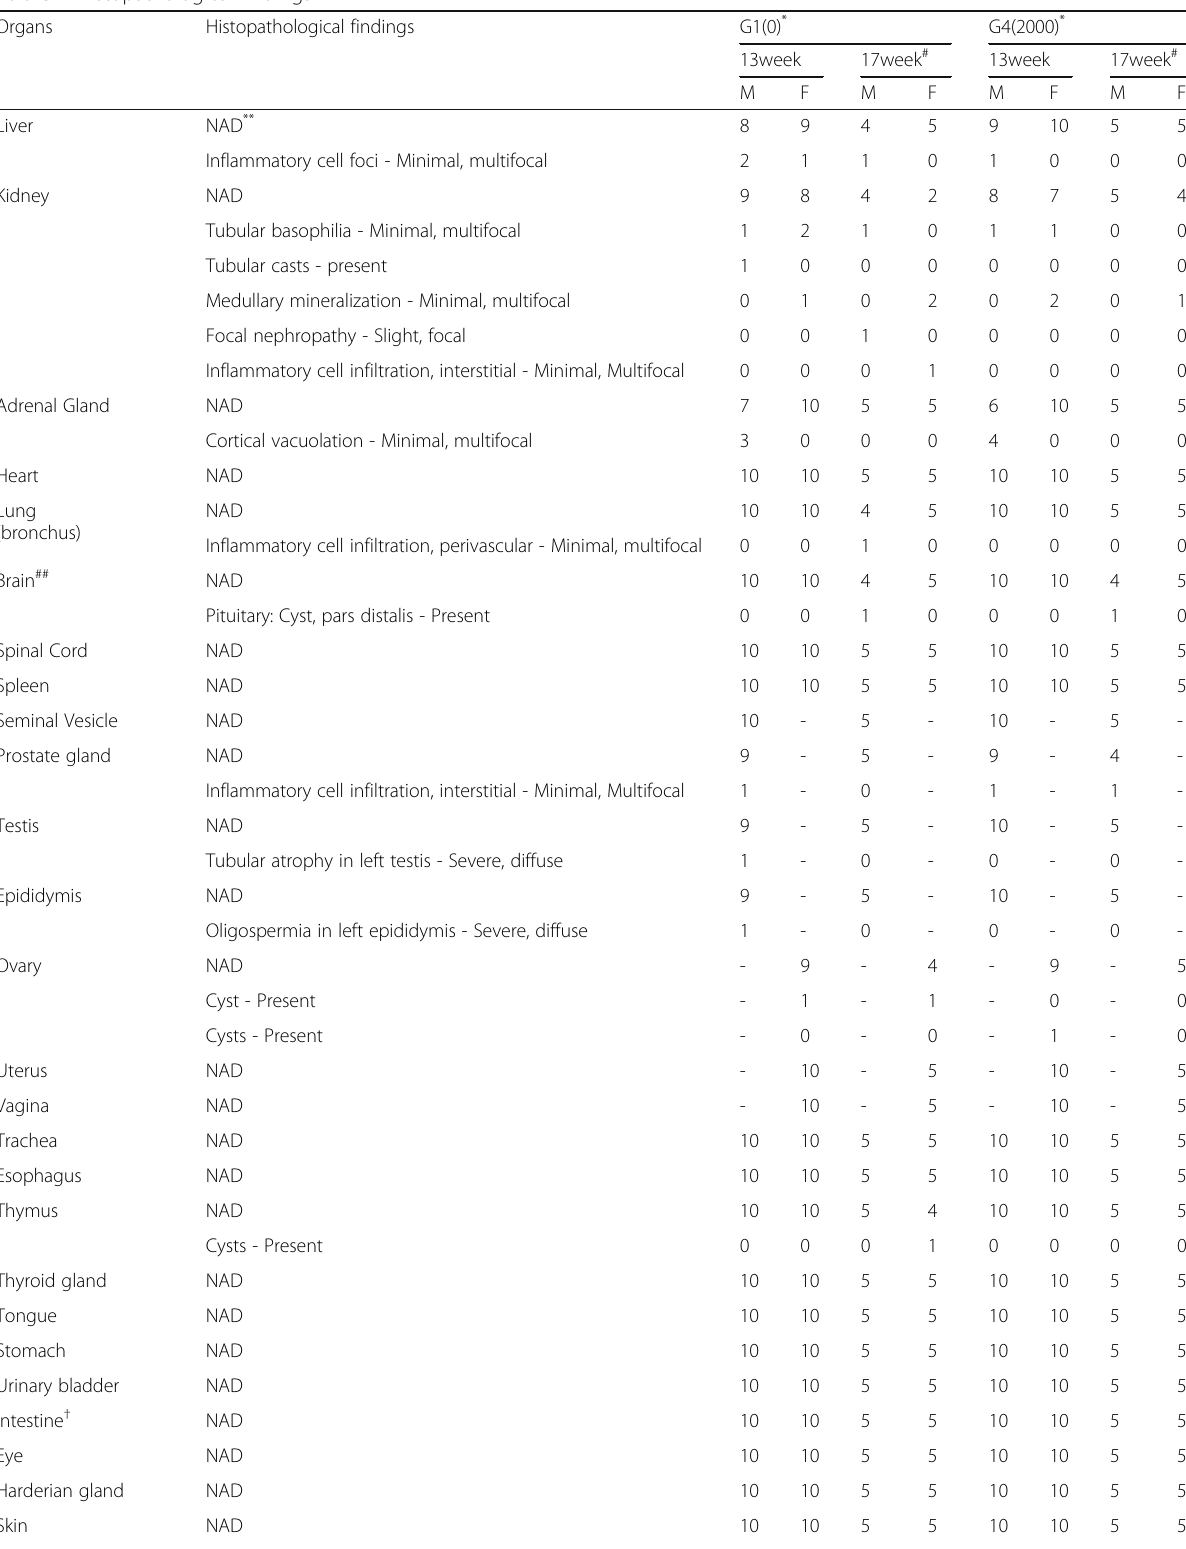
Table 7 Histopathological findings